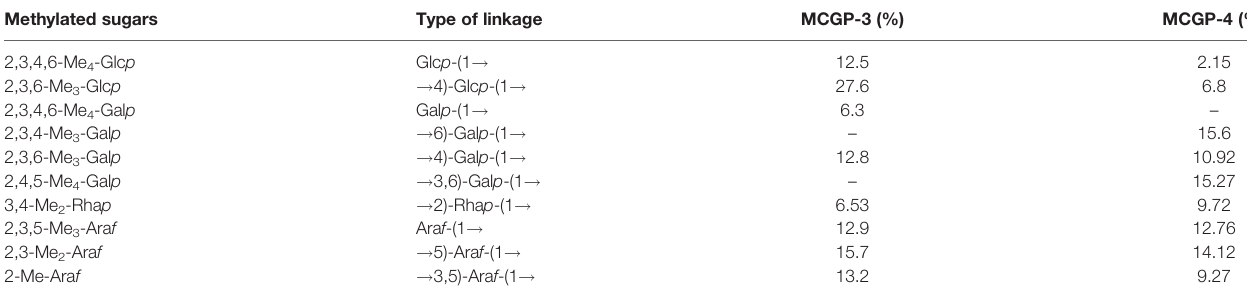
TABLE 2 | Results of methylation analysis of MCGP-3 and